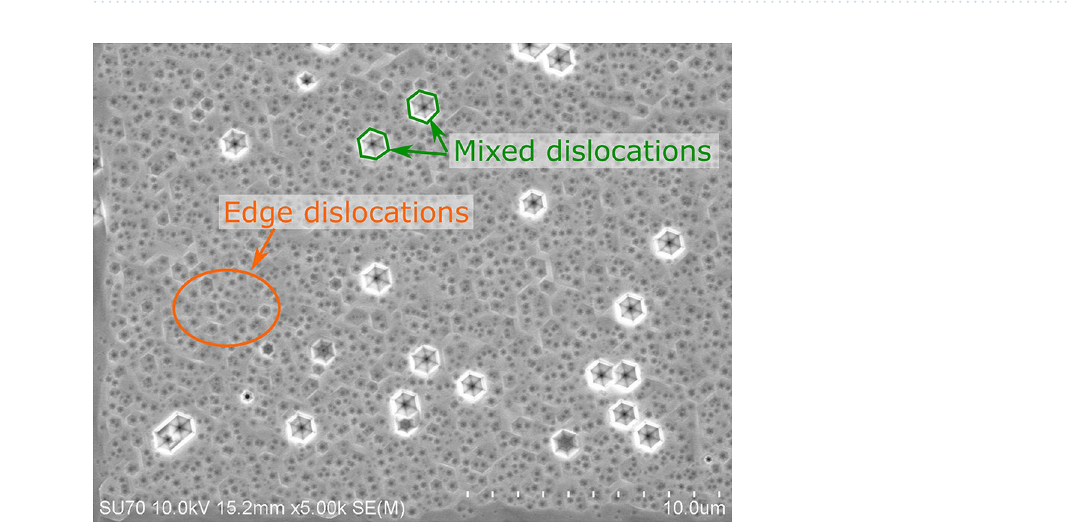
Figure 9. Intensity of electroluminescence on temperature dependence for laser diode structures emitting at different wavelengths.